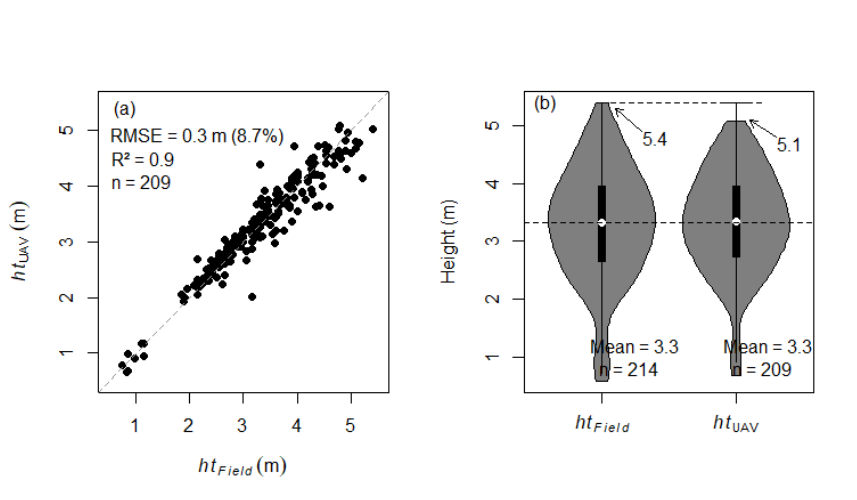
Figure 5. Scatterplot ( a ) and boxplot ( b ) of observed ( ht Field ) versus estimated ( ht UAV ) tree heights from UAV photogrammetry in a young Eucalyptus stand. The dashed line in ( b ) represents the mean value of ht Field .